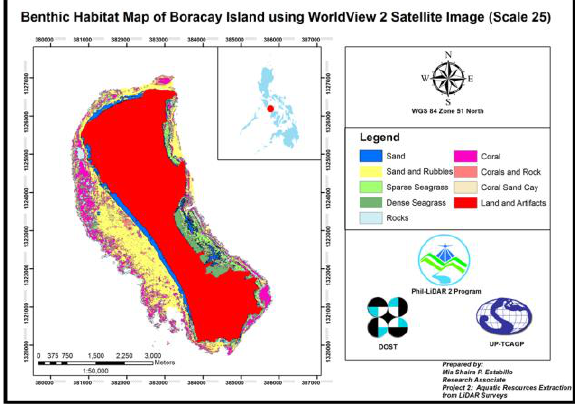
Figure 7. Benthic habitat map derived from Worldview image